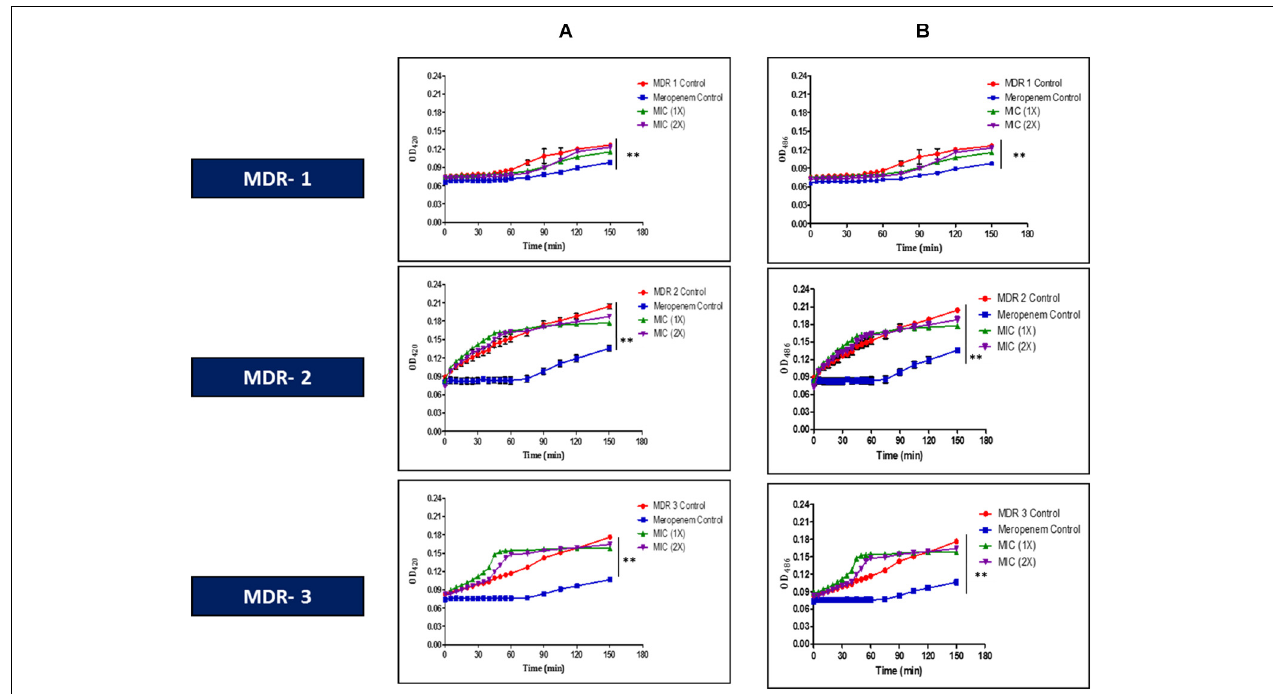
FIGURE 1 | In vitro membrane permeability assay of Lfcin (17–30) in MDR-EAEC strains. MIC (1 × and 2 × ) concentrations of Lfcin (17–30) against MDR-EAEC strains employing ONPG (A) and nitrocefin (B) , expressed as a function of time at 37 ◦ C. Hydrolysis of ONPG by β -galactosidase was used to monitor inner membrane permeabilization by absorbance at 420 nm, while hydrolysis of nitrocefin by β -lactamase was used to monitor outer membrane permeabilization by absorbance at 486 nm (*** P < 0.001; ** P <